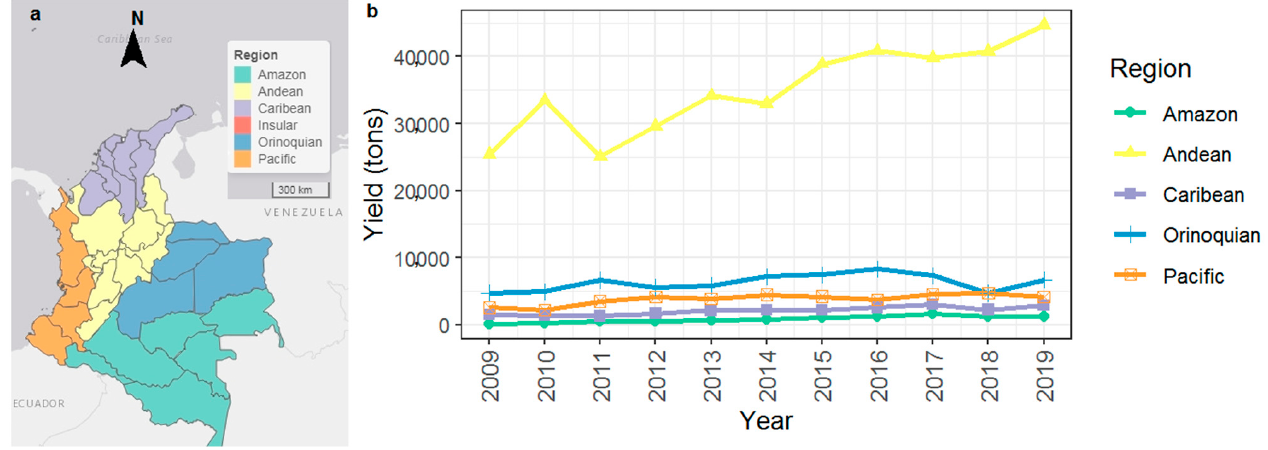
Figure 1. Cacao production according to ( a ) geographical region, ( b ) variation from 2009 to 2019. Source [24].